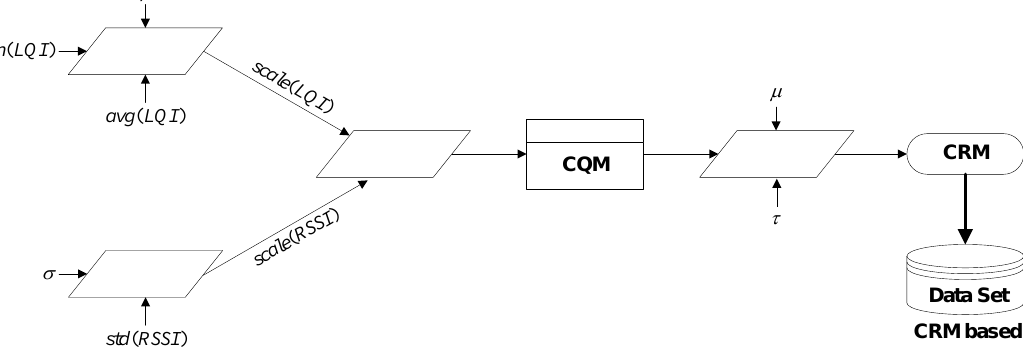
Figure 2. Diagrammatic representation of channel rank measurement (CRM) metric-based training dataset